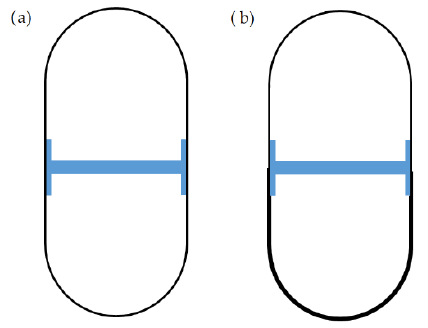
Figure 12. Cross-section of the designed capsules. ( a ) With the same wall thickness, ( b ) with different wall thicknesses [120].